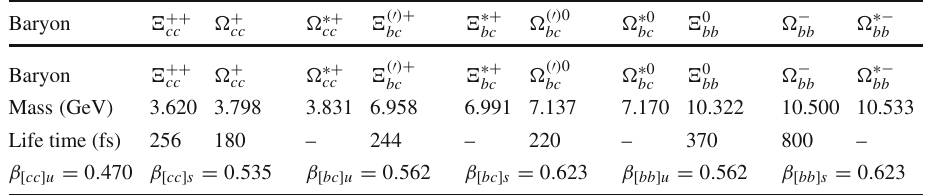
Table 3 Numerical results for the form factors of spin-1/2 to spin-1/2 transitions. The F ∗ ( 0 ) indicates the form factors simplified in the heavy quark limit in Eq.